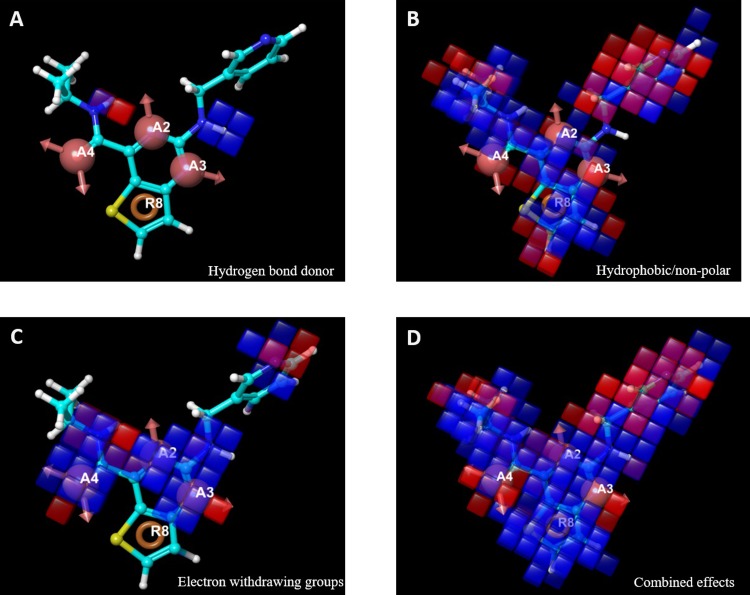
Pictorial representations of the positive (cobalt) and negative (red) coefficients that contribute to A2A antagonist activities, from hydrogen bond donor (A), hydrophobicity (B), electron withdrawing groups (C), and the combined effects (D).